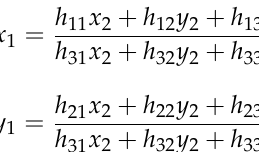
Figure 10. Image plane, red plane, and world plane, in light green, relations by homography.